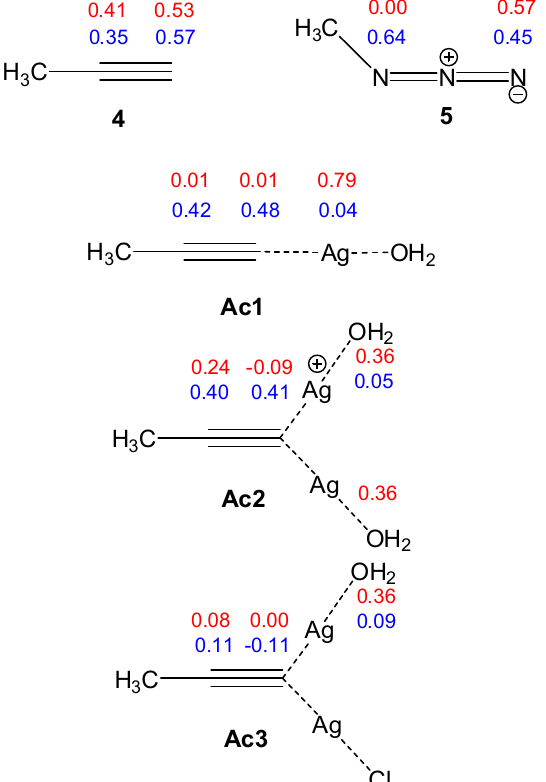
Figure 5. Electrophilic P + Parr (red) and nucleophilic P − Parr (blue) functions at 4 , 5 and Ac1 , Ac2 , and Ac3 .